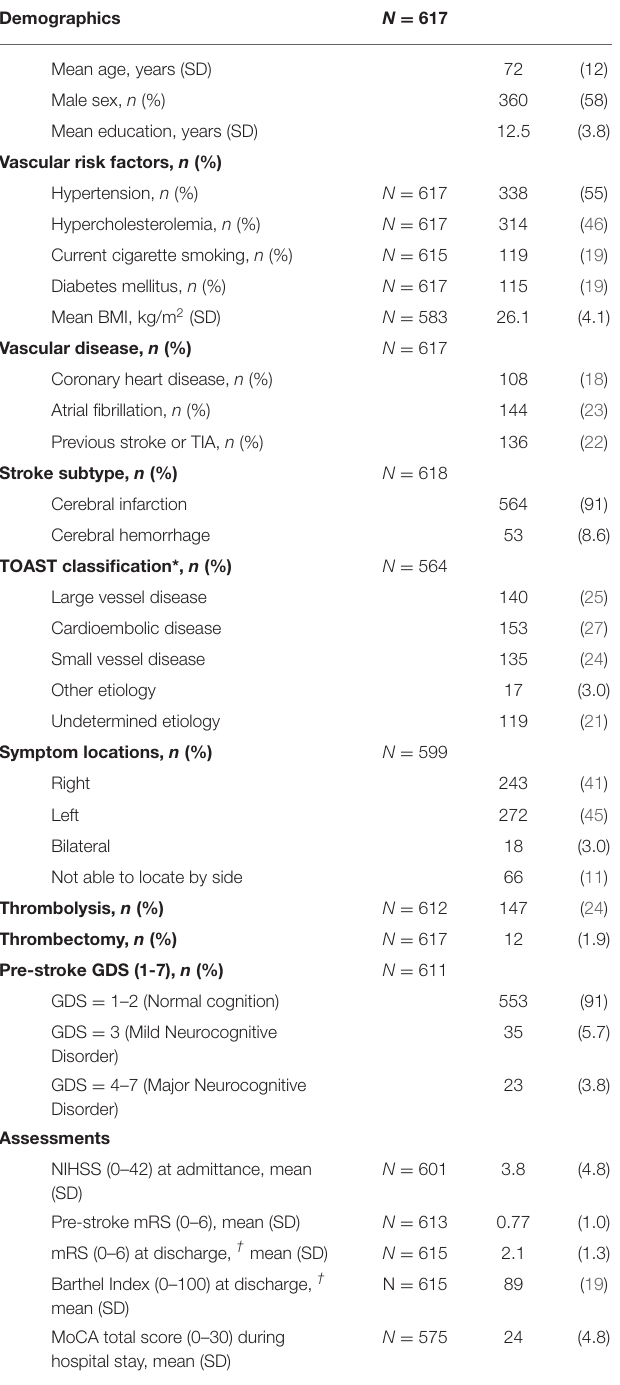
TABLE 1 | Baseline